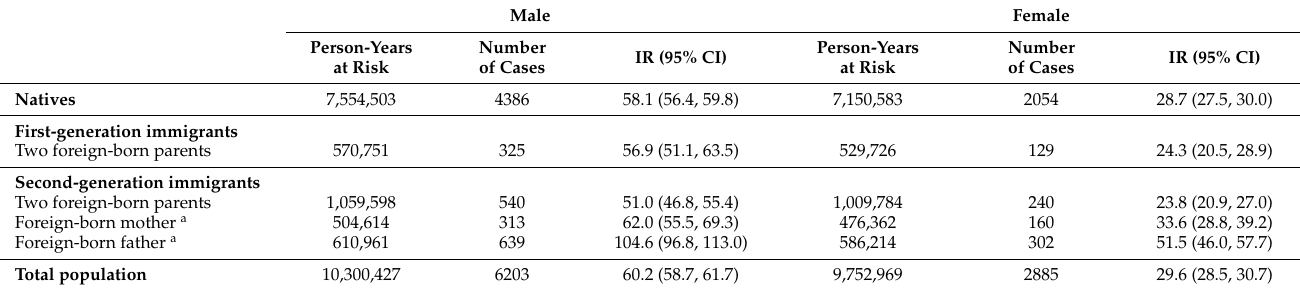
Table 2. Incidence rates of Conduct Disorder (per 100,000 person-years) among participants 4–16 years at baseline in Sweden, 2001–2015.